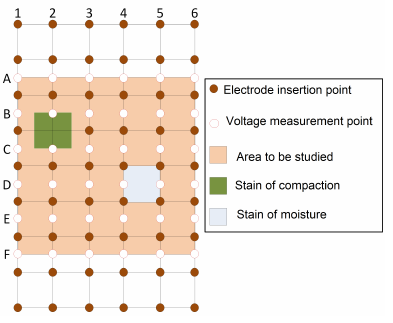
Figure 13. Definition of area and application of